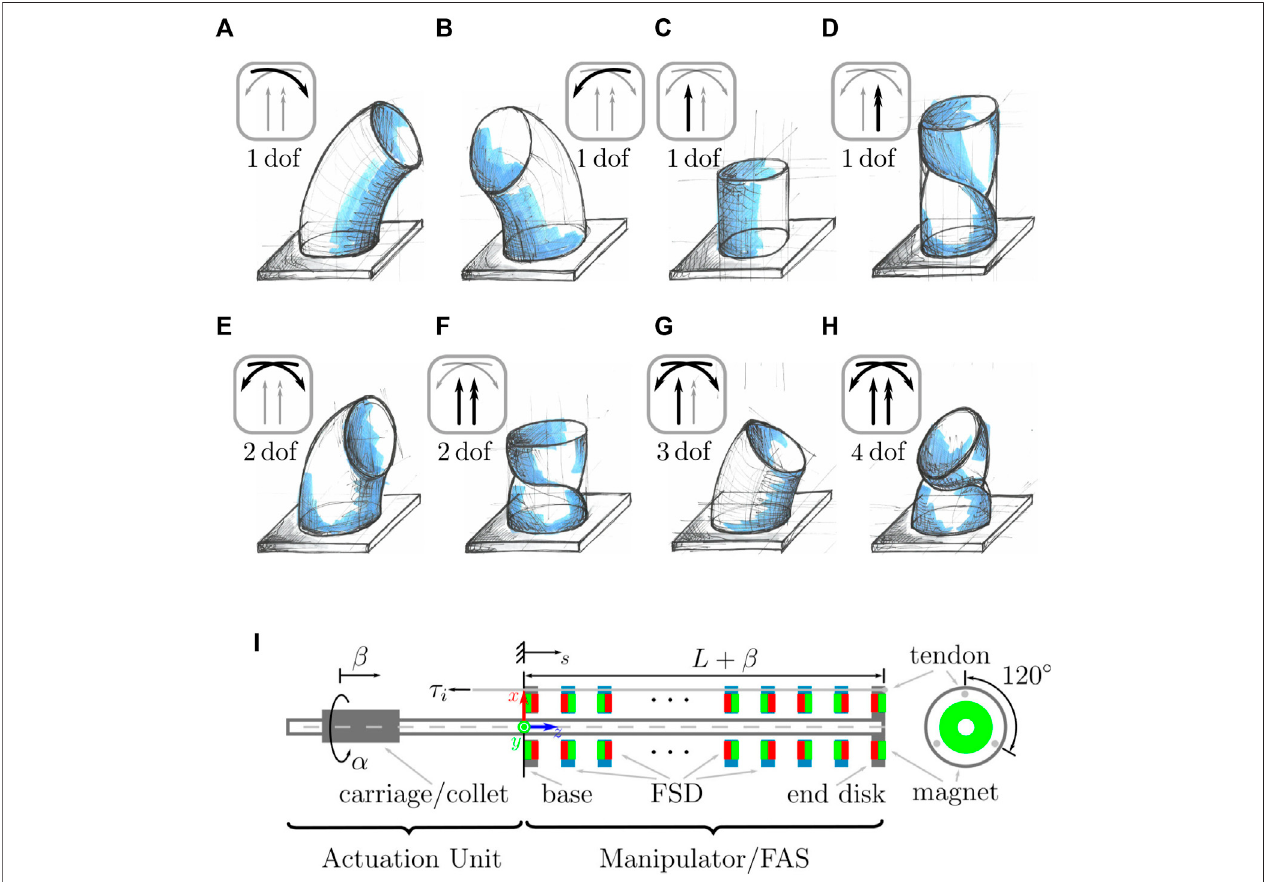
FIGURE2| Degreeoffreedomofasinglesegmentofacontinuumrobotrepresentedasabluecontinuumstructure. (A) κ x isaonedofbendinginaplane. (B) κ y isa onedofbendinginanotherplanebeingperpendiculartothe fi rstbendingplane. (C) Using β ,thechangeoflengthasextensionorcontractionofasegmentisonedof. (D) onedof twist along the centerline of the segment induces by α . (E) Bending in both bending planes results in twodof. Note that bending in one plane, e.g. κ (cid:1) with an additional rotation of the banding plane, e.g. ϕ = arctan2 ( κ y , κ x ), yields the same twodof result, where κ and ϕ are directly actuated. (F) Variable segment length with the ability to independently twist results in twodof. (G) Variable segment length additional to both bending are in total threedof. (H) The four dof envisioned designcanactuatealldegreeoffreedomwhichincludebothbending,variablesegmentlength,andtwisting. (I) SchematicsofaTDCRprototypecomposedofoneFAS. The green and red colors indicate the alternating poles of the magnets used for the type-III FSD. This TDCR prototype is capable of all illustrated motions.